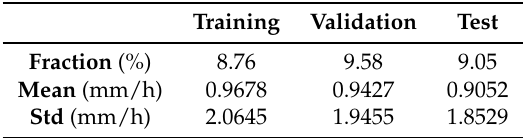
Table 2. The fraction of non-null precipitation events and the mean and standard deviation for the non-null precipitation rate measurements of the training, validation and test